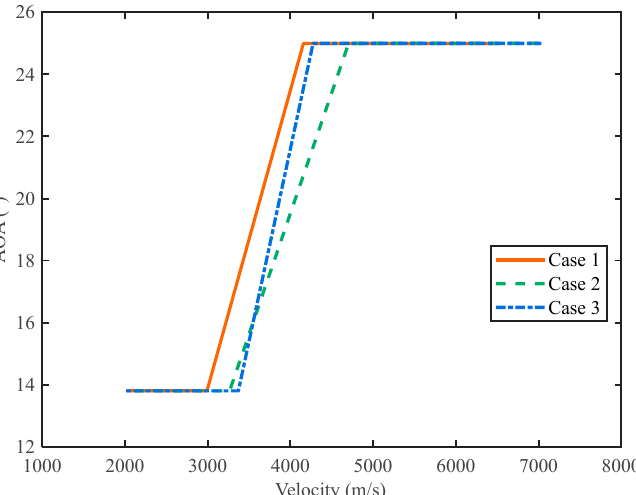
Figure 20. Velocity histories of the AOA.